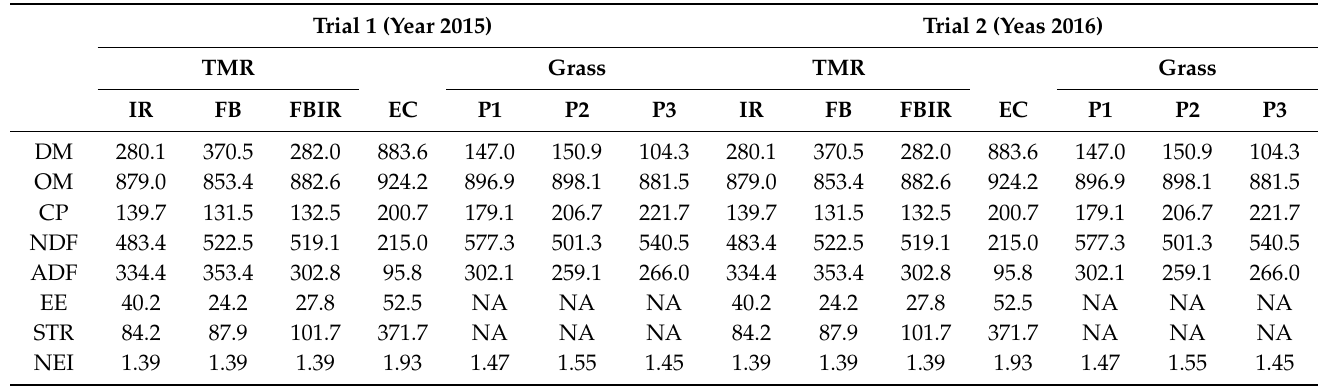
Table 4. Nutritional value and energy content of total mixed rations (TMR), extra concentrate (EC), and grass in each